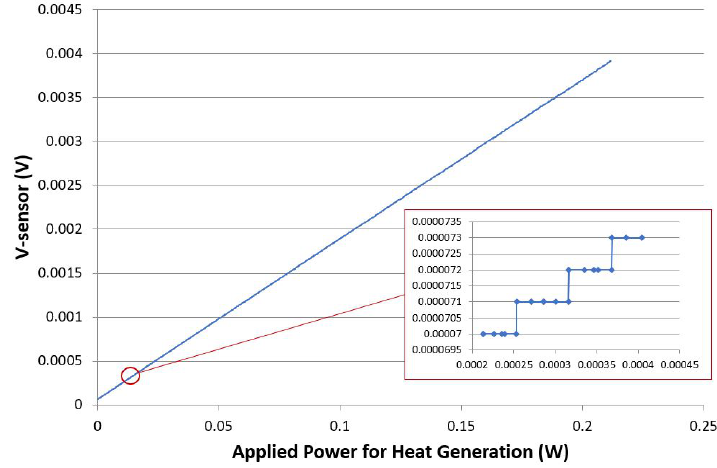
Figure 19. V out as function of the applied heat around the sensing element.